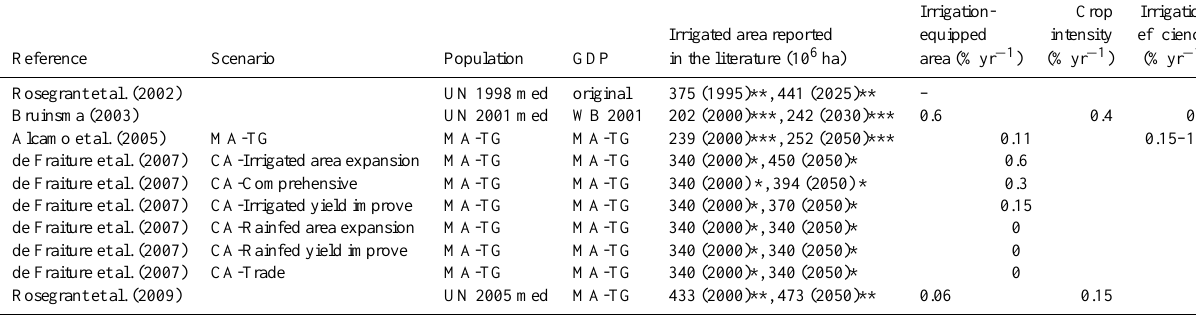
Table 2. Projection of irrigated area, crop intensity, and irrigation efficiency in earlier reports.